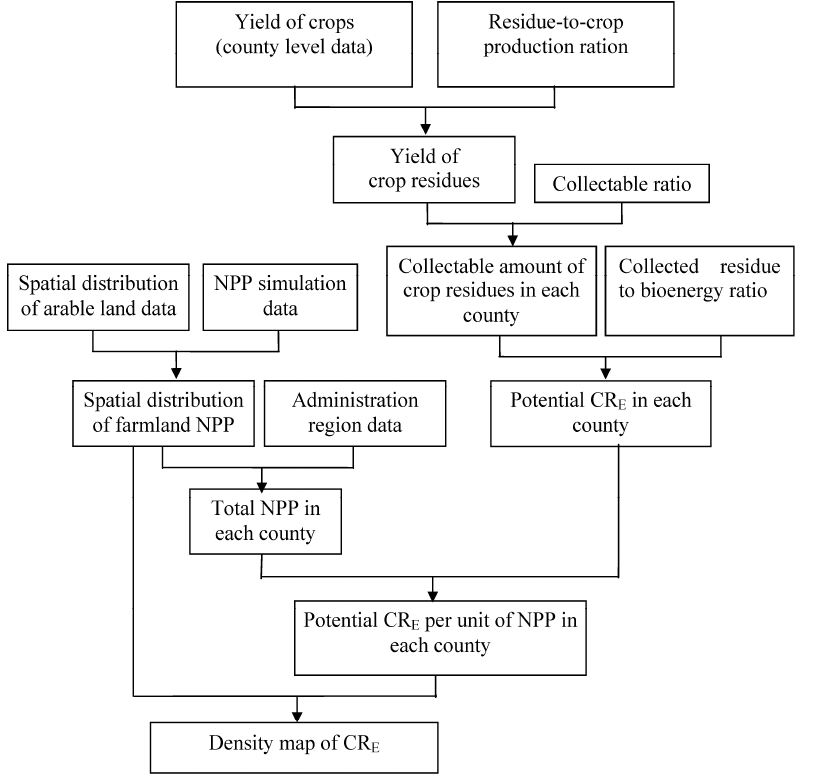
Figure 1. Flow chart for estimating the distribution of CR